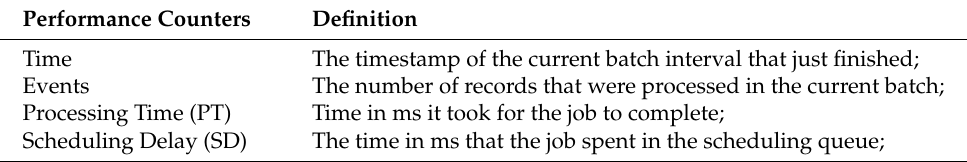
Table 2. Spark Performance Counters.